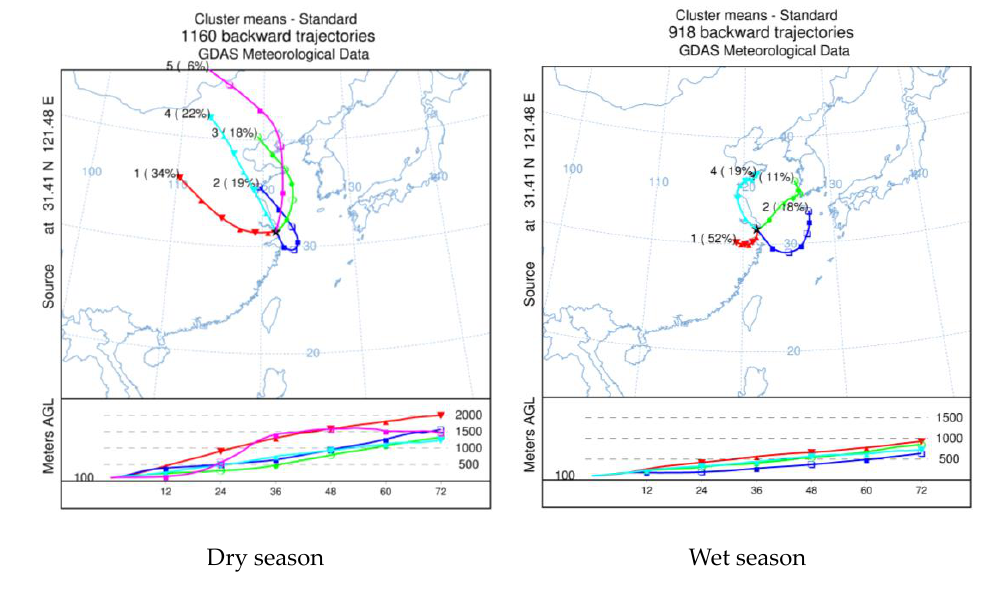
Figure 4. Trajectories clusters for dry and wet seasons of the YRDUA.